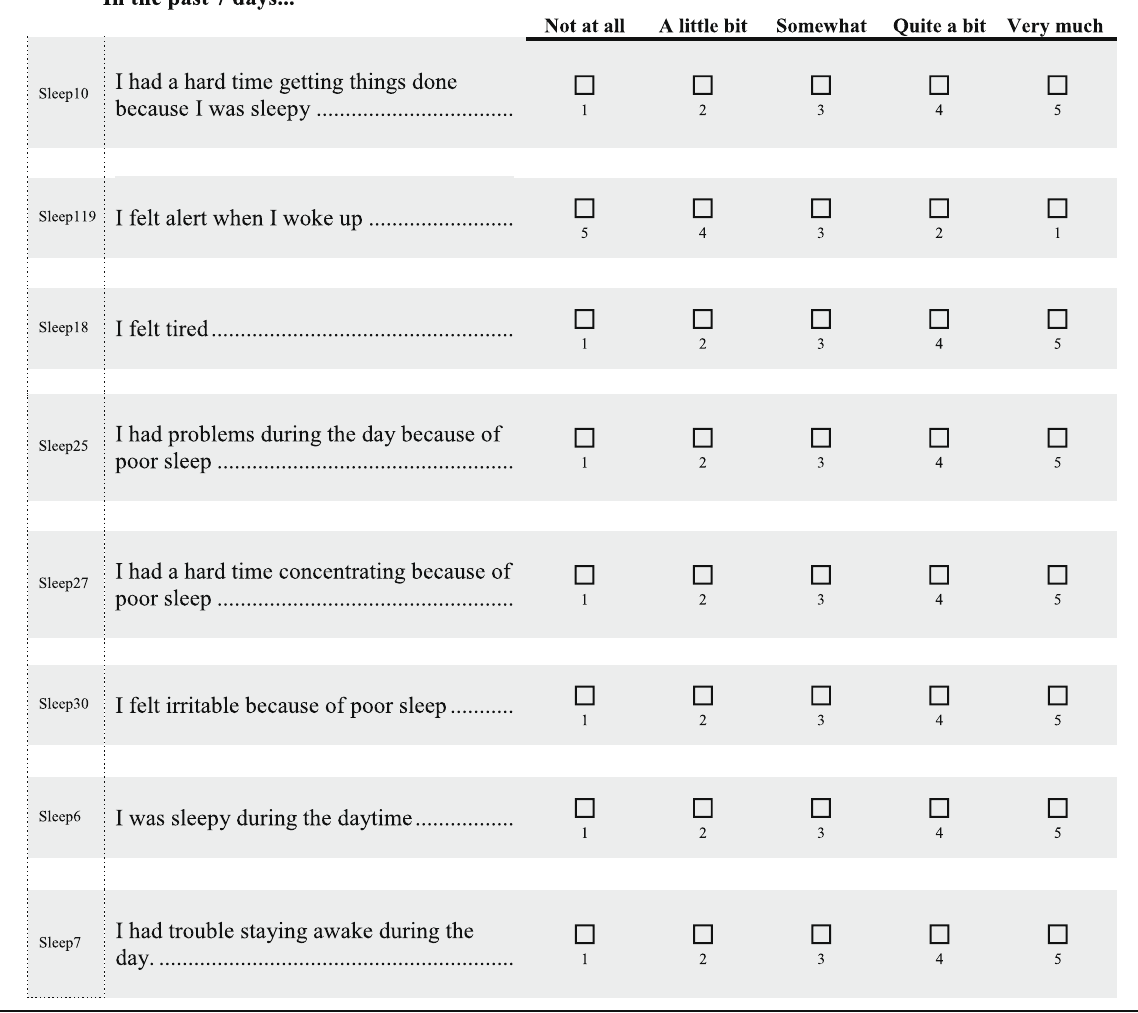
Table 1 PROMIS Sleep-Related Impairment Short Form 8a